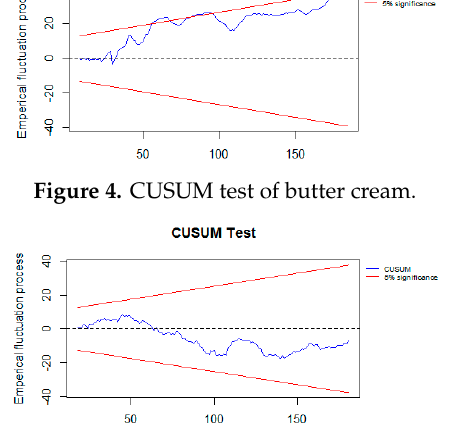
Figure 3. CUSUM test of kefir.